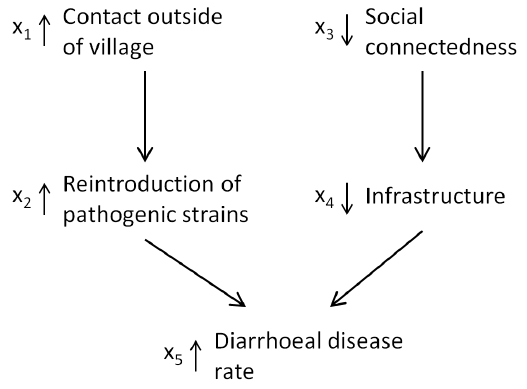
Figure 8. Causal diagram of the simplified application problem [23].